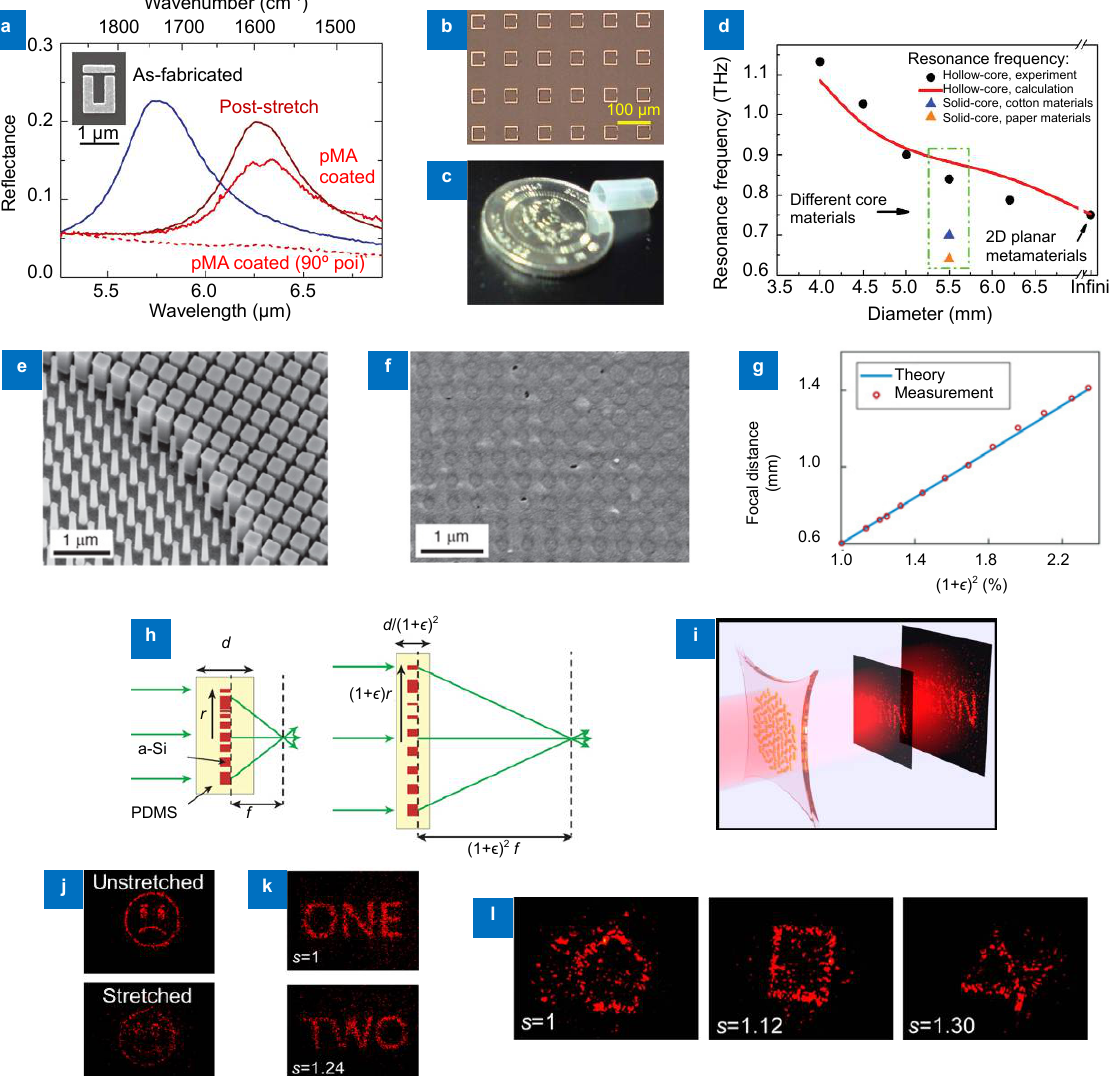
Fig. 14 | Flexible tunable metamaterials made on elastic substrates . ( a ) FTIR reflection spectra for the metamaterial with a coupling distance of 60 nm are shown. The inset shows SEM image of the fabricated sample. Image of ( b ) 2D planar metamaterial and ( c ) 3D terahertz metamaterial tube at a diameter of 4.00 mm. ( d ) Resonance frequency shifts as a function of core diameter for the hollow- and solid-core (cotton and paper) metamaterials tubes. SEM image of ( e ) the nano-posts before spin coating the first PDMS layer and ( f ) the nano-posts embedded in the PDMS. ( g ) Measured and analytically predicted focal distances (i.e. (1+ ε ) 2 × f ) for different strain values versus the square of the stretch ratio ((1+ ε ) 2 ). ( h ) A side view schematic illustration of a dielectric metasurface microlens that by stretching with a stretch ratio of (1+ ε ), the focal distance changes by (1+ ε ) 2 . ( i ) Schematic illustration of the metasurface hologram on the PDMS substrate. ( j ) and ( k ) Experimentally measured hologram images at an image plane 200 μ m from the metasurface for a device that is not stretched and stretched. ( l ) Experimentally captured hologram images at a distance of 340 μ m from the metasurface when the device is unstretched, stretched 112%, and 130%. Figure reproduced from: ( a ) ref. 230 , American Chemical Society; ( b – d ) ref. 72 , John Wiley and Sons; ( e – h ) ref. 70 , John Wiley and Sons; ( i – l ) ref. 231 , American Chemical